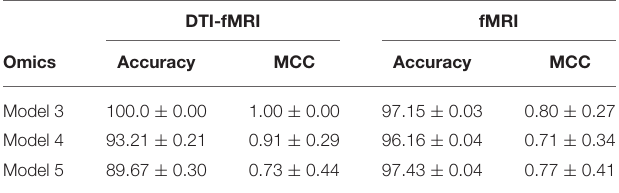
TABLE 5 | Comparison of model performance between DTI-fMRI data and fMRI data.